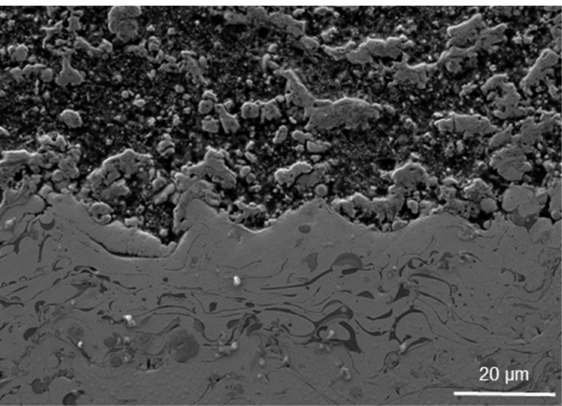
Figure 9. Bond coat/top coat interface of Al 2 O 3 /TZ-3YS coating at 5000 ×